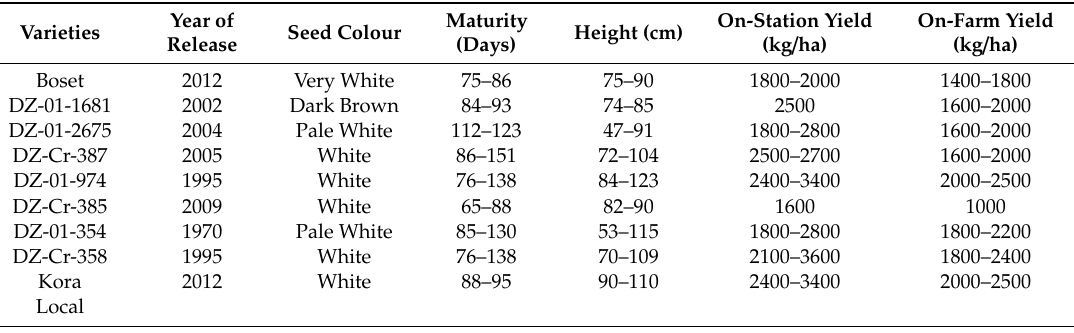
Table 2. General description of the te ff varieties used for the experiments.